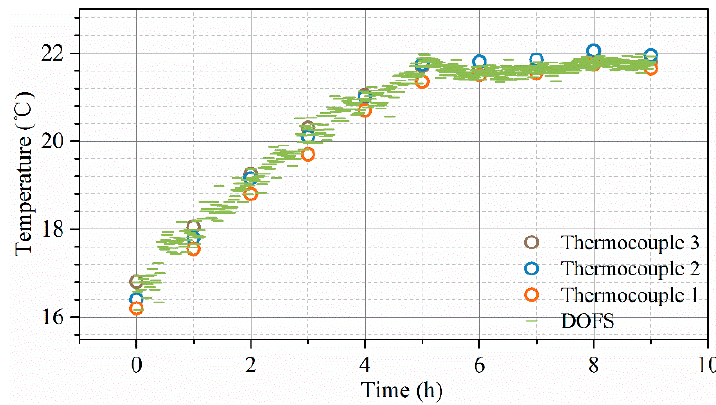
Figure 6. Ambient temperature detecting results during the whole test.